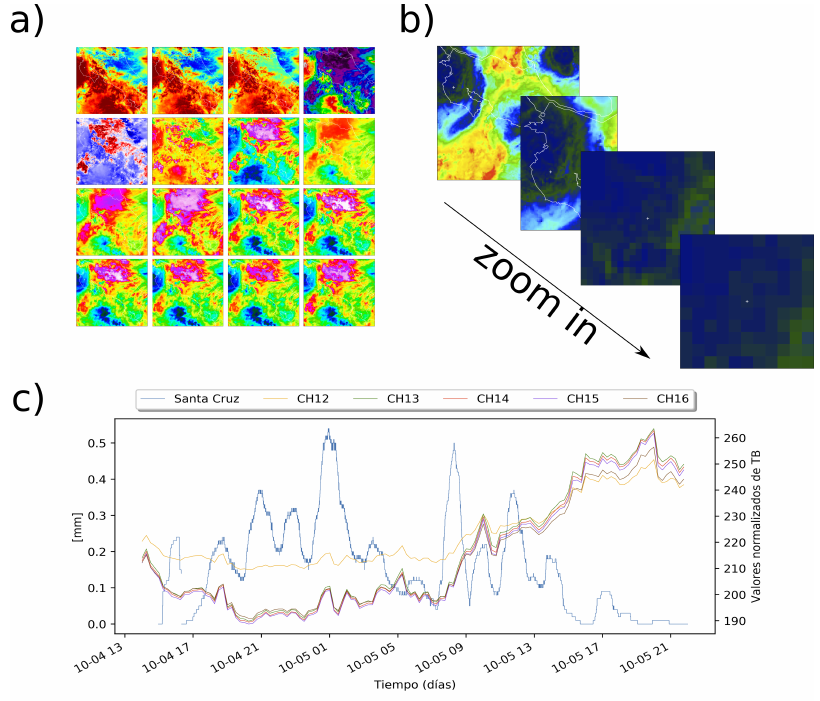
Figure 1. In this figure, some stages of a learning activity used during the FGP process are shown. ( a ) All 16 channels of GOES-East were animated in high resolution for a period of five days (prior to, during and after Tropical Storm Nate’s effects). ( b ) Different zoom levels were used to bring the student from the big picture to the regional effects observed by the satellite. ( c ) One of the figures used by the student to contrast surface measurements of precipitation (blue line) and channel variation in time (other five lines) is included as an example of the educational resources. The titles are in Spanish as the products were developed in that language.